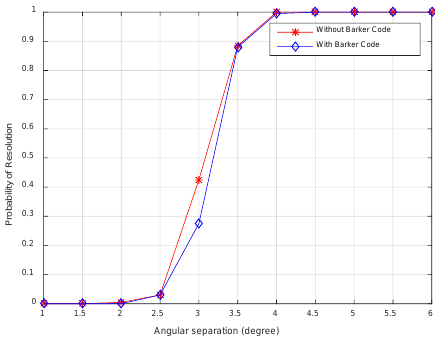
Figure 12. Resolution probability against angular separations.